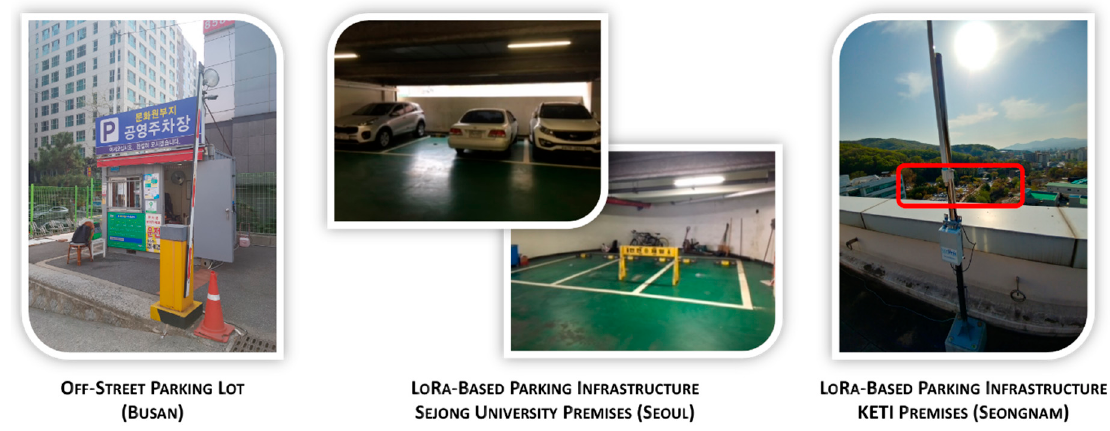
Figure 8. IoT parking deployment examples in the cities of Busan, Seoul and Seongnam.